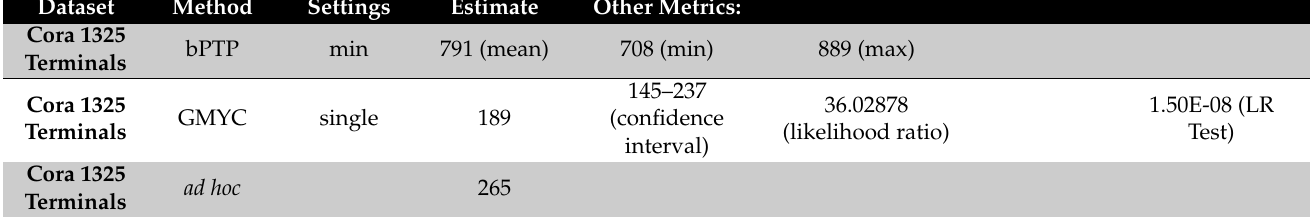
Table 3. Species delimitation methods utilized and their respective